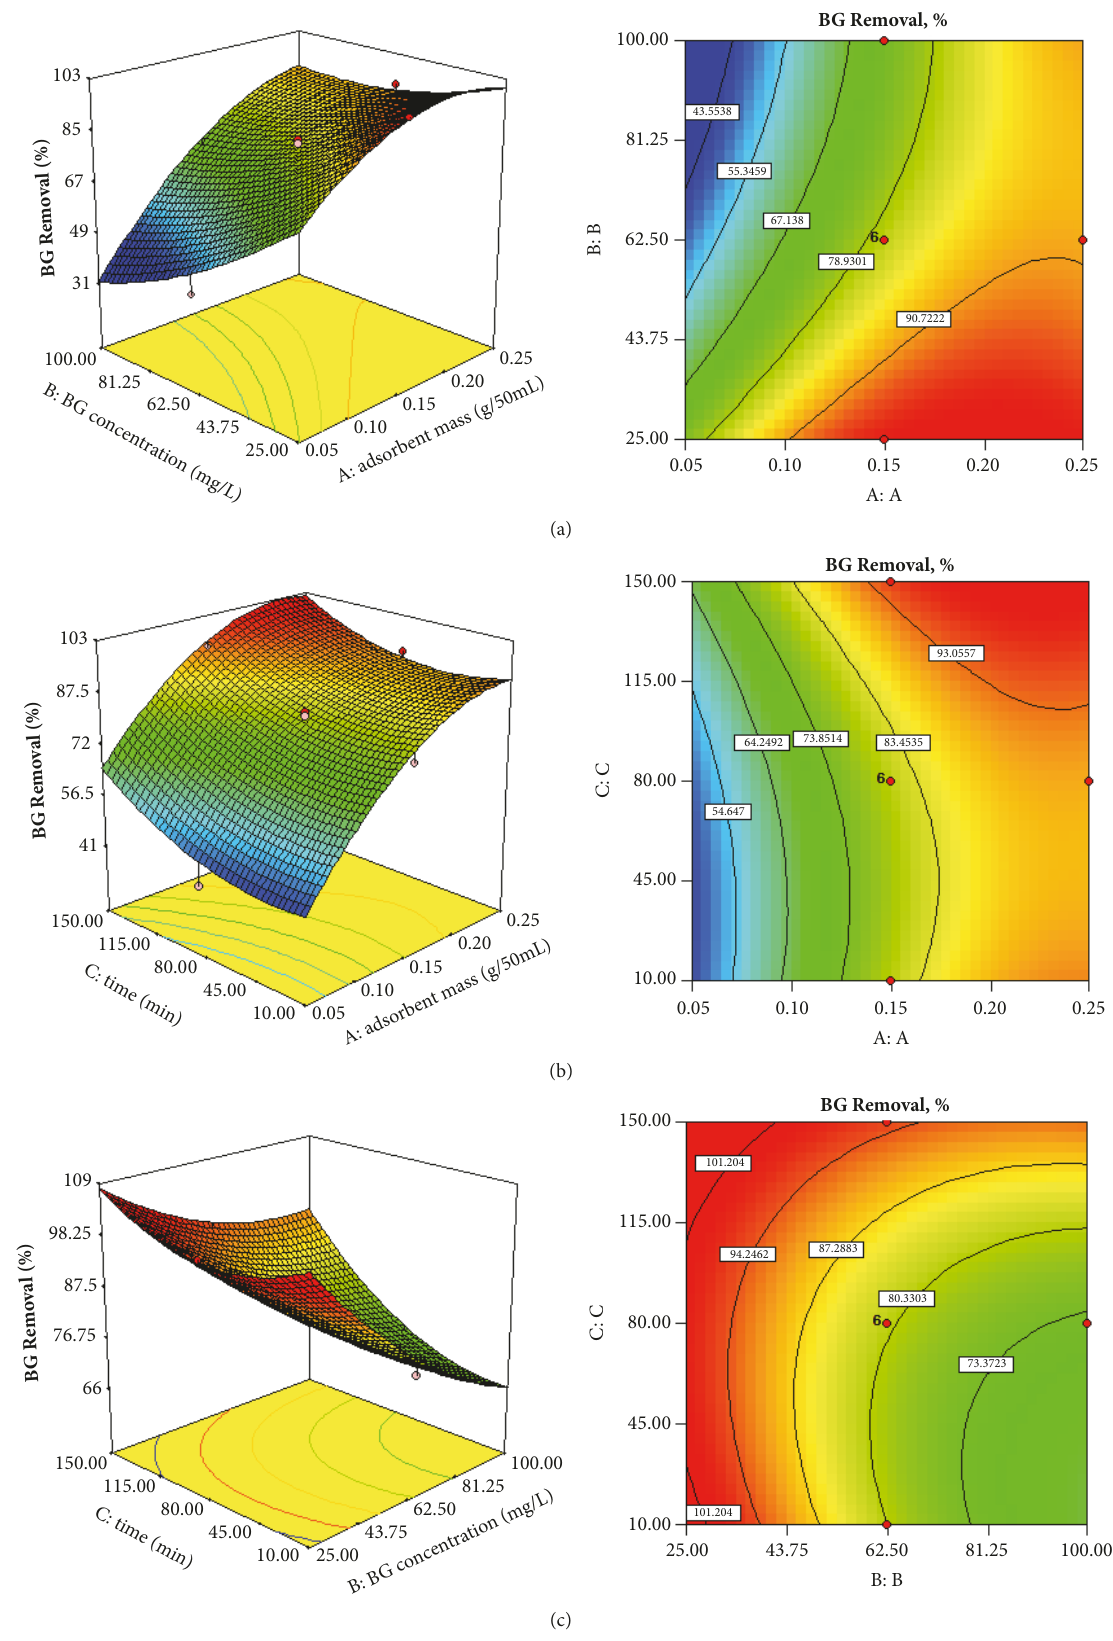
Figure 6: 3D response surface and 2D contour plots of combined effects of (a) AB , (b) AC , and (c) BC on the BG removal by onto poly(VP-